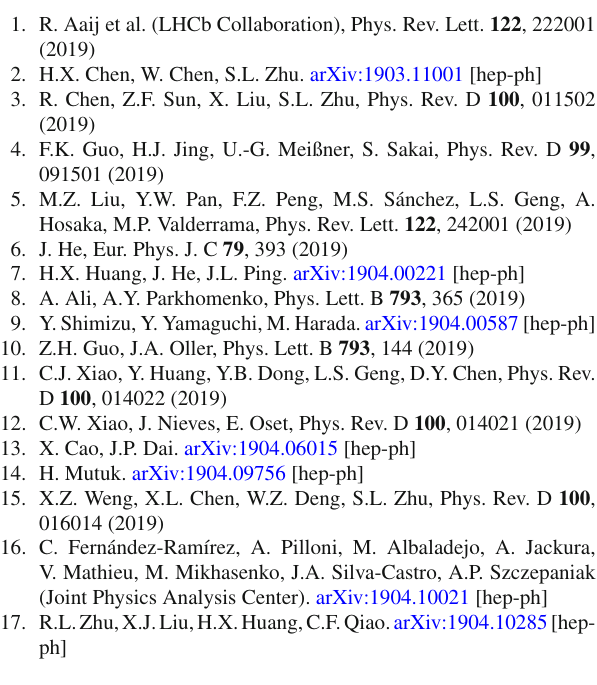
√ s 0 = 4 . 7 ∼ 4 . 9 GeV. The √ s 0 = 4 . 7 GeV, 2 . 2 ∼ 3 . 1 GeV 2 √ s 0 = 4 . 9